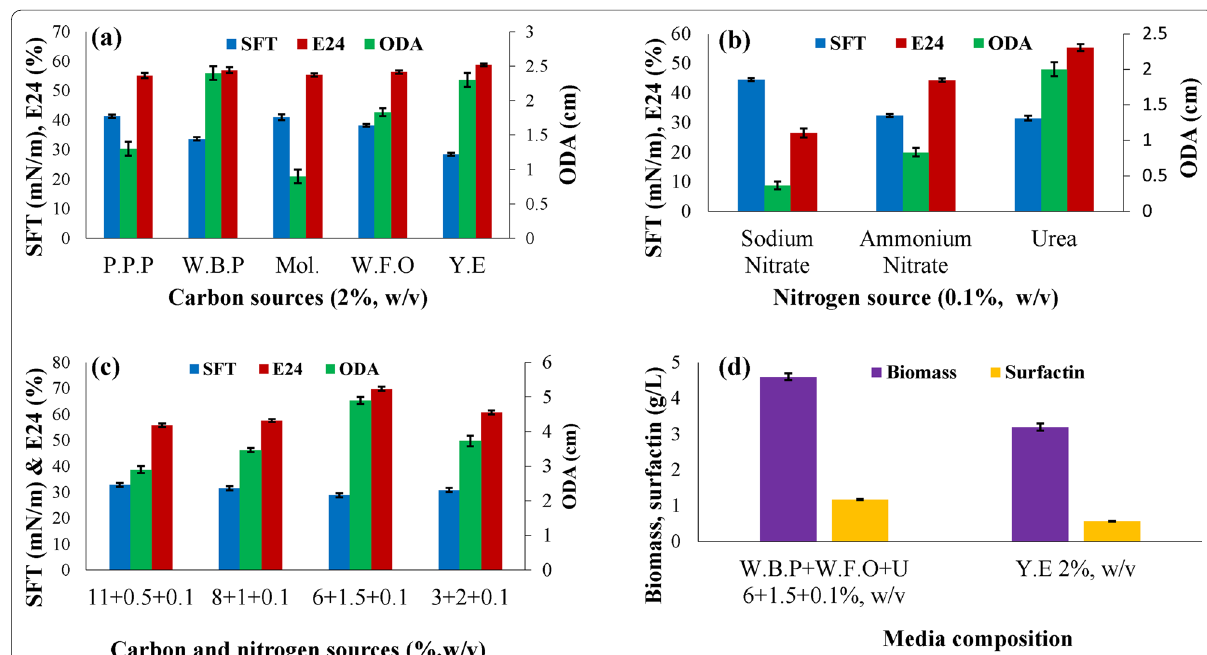
Fig. 1 SFT, E24 and ODA values for lipopeptide production by Bacillus subtilis SNW3 a with alternative carbon sources used individually, b different nitrogen sources, c with a combination of carbon and nitrogen energy sources and d production analysis of surfactin under optimized conditions with yeast extract as a reference, in shake flask fermentation at 30 °C. P.P.P: potato peels powder; W.B.P: white beans powder; Mol.: molasses; W.F.O: waste frying oil; Y.E: yeast